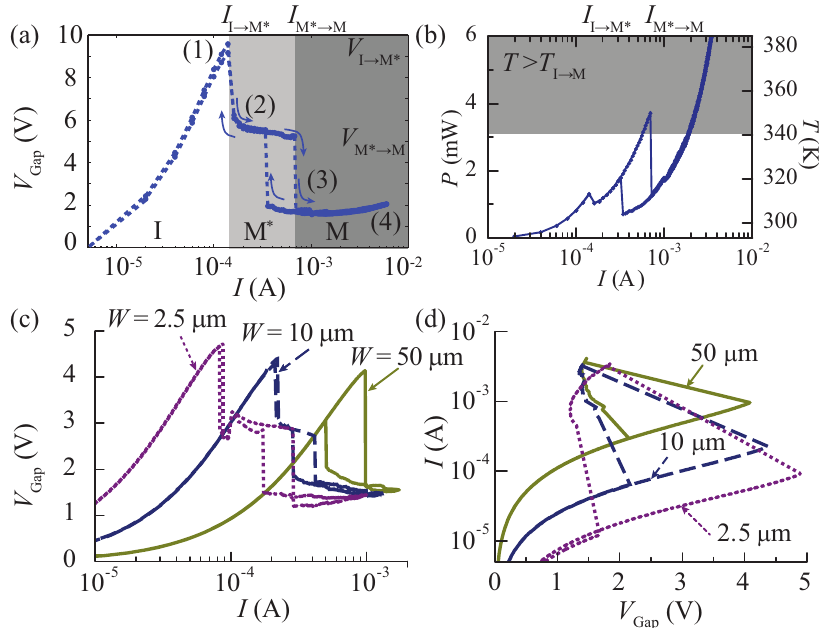
Figure 3. The ( a ) voltage-current and ( b ) power-current relationship of a the VO L = 5 µ m and W = 10 µ m. The expected temperature of the VO axis. ( c ) The voltage-current and ( d ) current-voltage relationship of a the VO L = 1 . 25 µ m and W = 2.5 µ m, 10 µ m and 50 µ